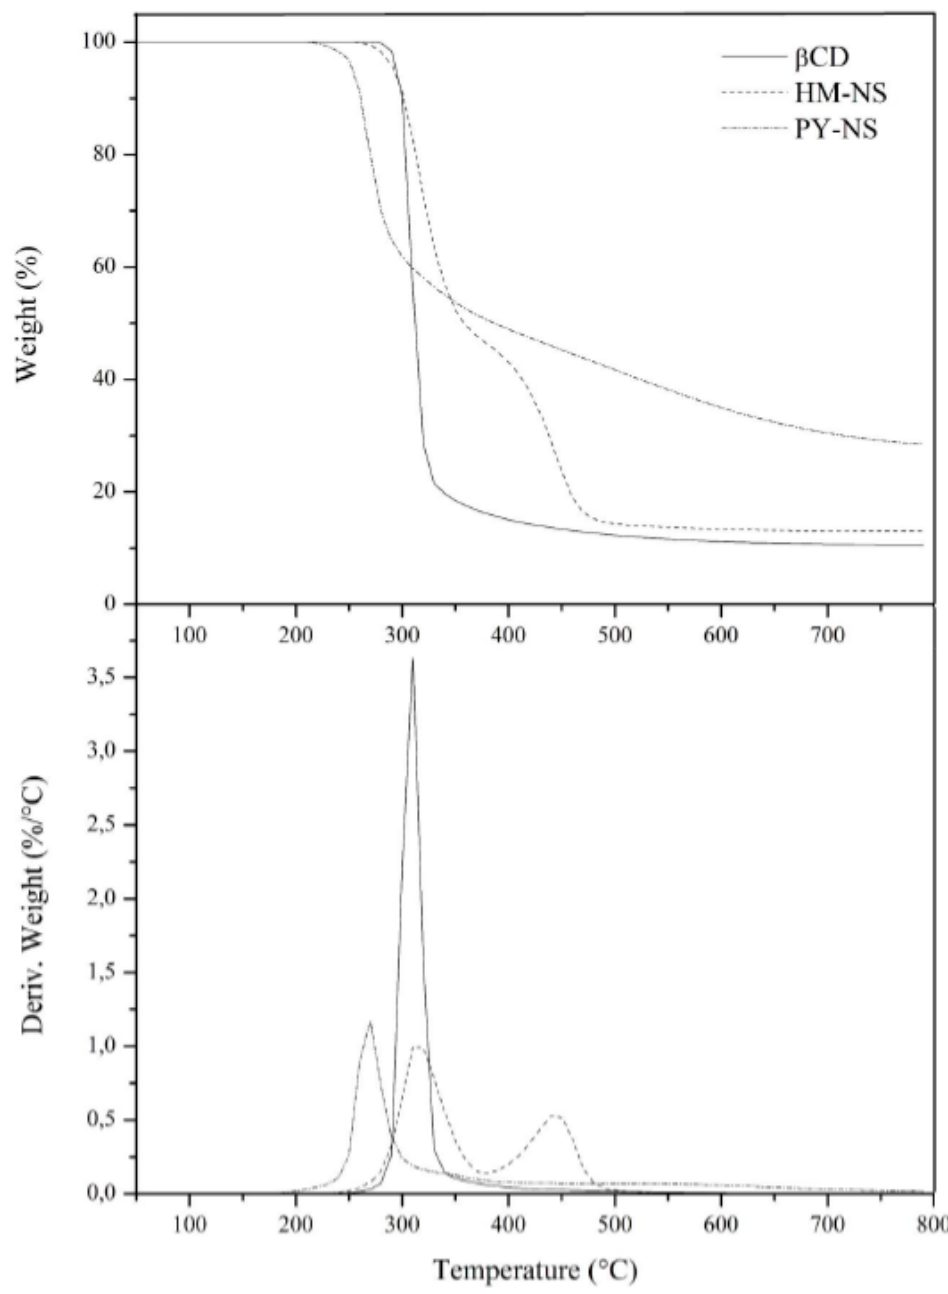
Figure 1. Thermogravimetry (TGA) (nitrogen flow, heating rate 10 ◦ C/min) of β -cyclodextrin (BCD) and hexamethylenediisocyanate (HD-NS), pyromellitic dianhydride (PY-NS). Reprinted with permission from ref. [46].